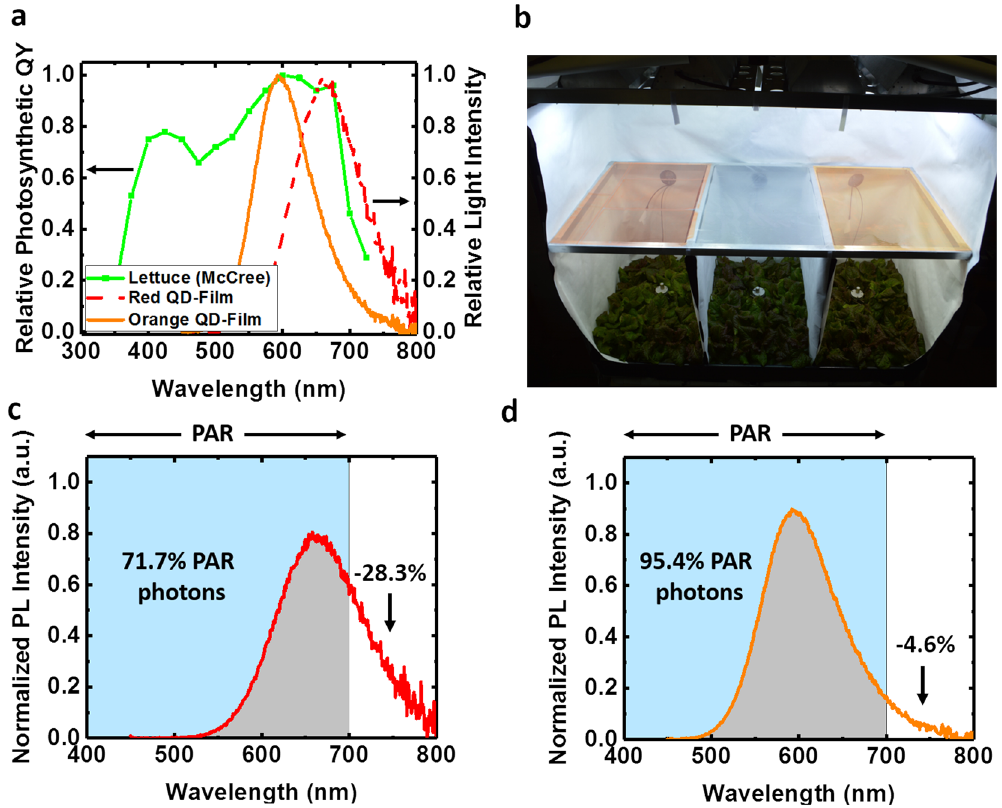
Fig. 1 Luminescent properties of QD fi lms. a The emission spectra of the two QD fi lms with peak PL emissions of 600 nm (orange, solid line) and 660 nm (red, dashed line) overlapped on the photosynthetic response curve for lettuce (green, squares) measured by McCree 5 . b Photograph of the PGTC for lettuce plant trials. Three light treatment areas were used to compare different light spectra created by QD fi lms (left and right) to a Control fi lm (middle) under similar light intensity. The spectra of QD fi lms with peak emission of ( c ) 660 nm and ( d ) 600 nm were normalized to have an area of 1 and then integrated over PAR wavelengths (400 – 700 nm) to determine the portion of the emission that was outside of PAR.